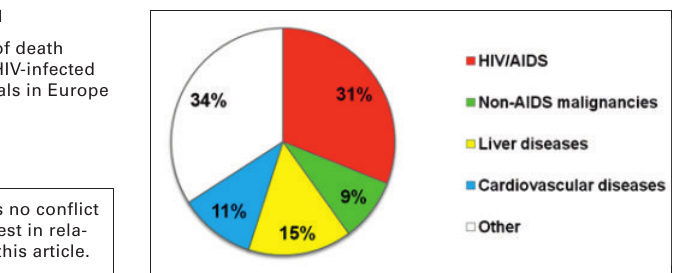
Therapeutic concepts and threshold when to start cART have changed over time, in view of lower long- term toxicity of anti- retrovirals and im- proved survival of treated individuals. Compiled from Benson et al. at http://aidsinfo.nih.